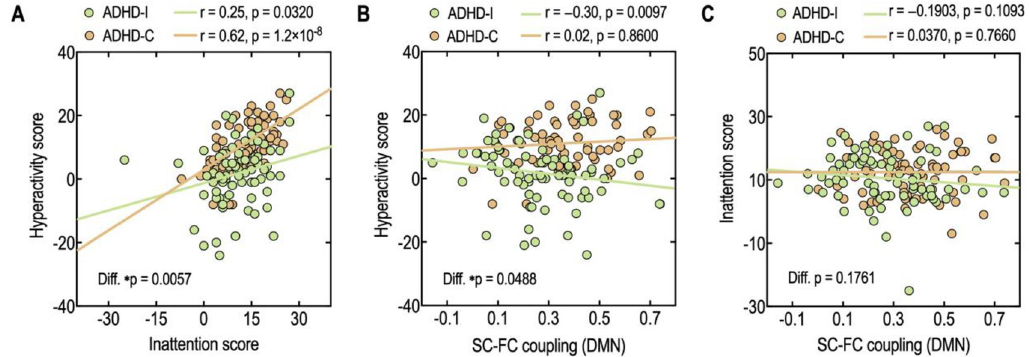
Fig 5. Relationship between inattention and hyperactivity (A), between SC-FC coupling in the DMN and hyperactivity score (B) between SC-FC coupling in the DMN and inattention score (C) in ADHD-I and ADHD-C. Diff: statistical significance of the two different correlation coefficients.